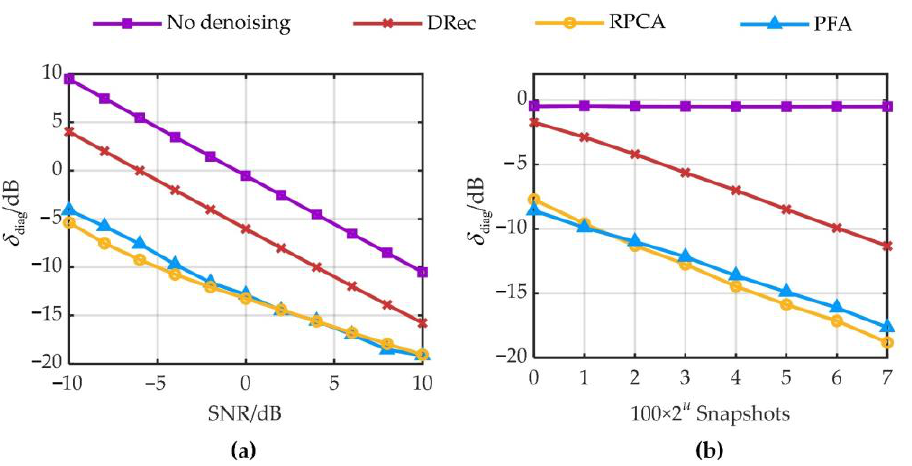
Figure 5. Diagonal reconstruction errors under different SNRs and different numbers of snapshots: ( a ) different SNRs with 1000 snapshots; ( b ) different numbers of snapshots with SNR = 0 dB.